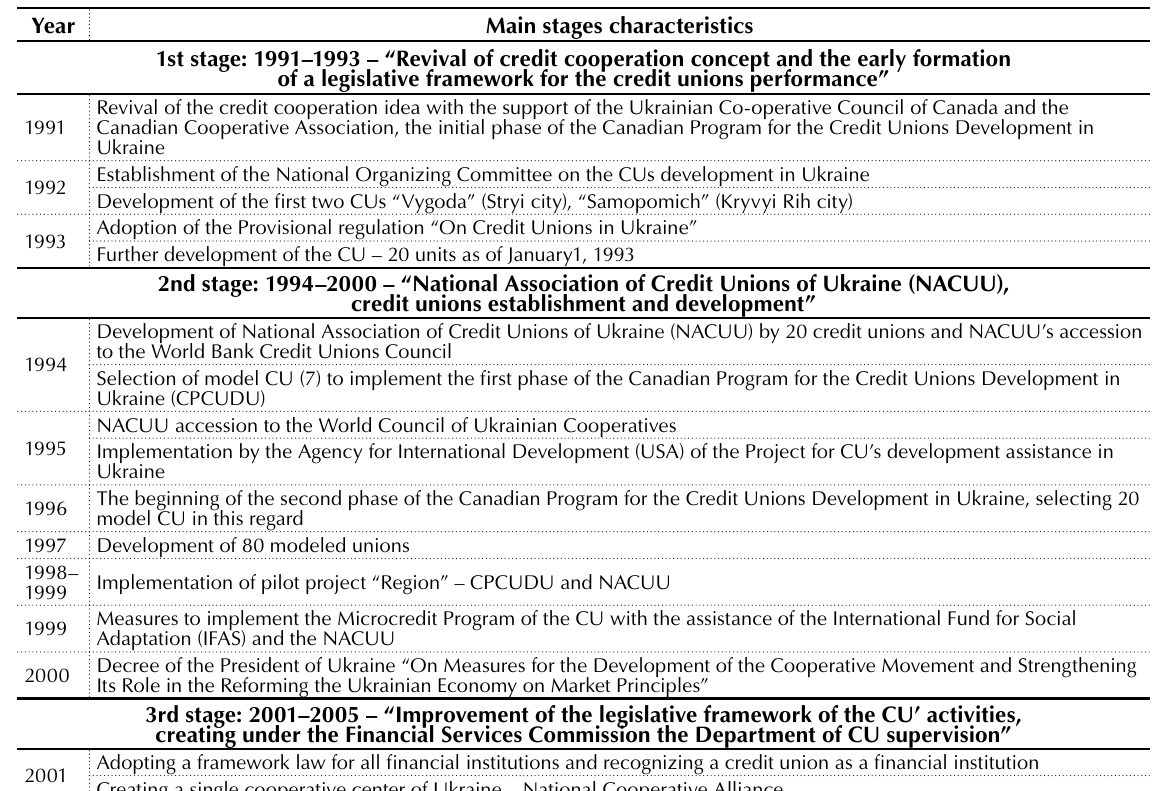
Table 1. Main stages of credit-cooperation movement transformations in Ukraine in 1991–2016 Source: prepared by authors based on Balaban and Sokolova (2012, p. 42), The National Commission for State Regulation of Financial Services Markets